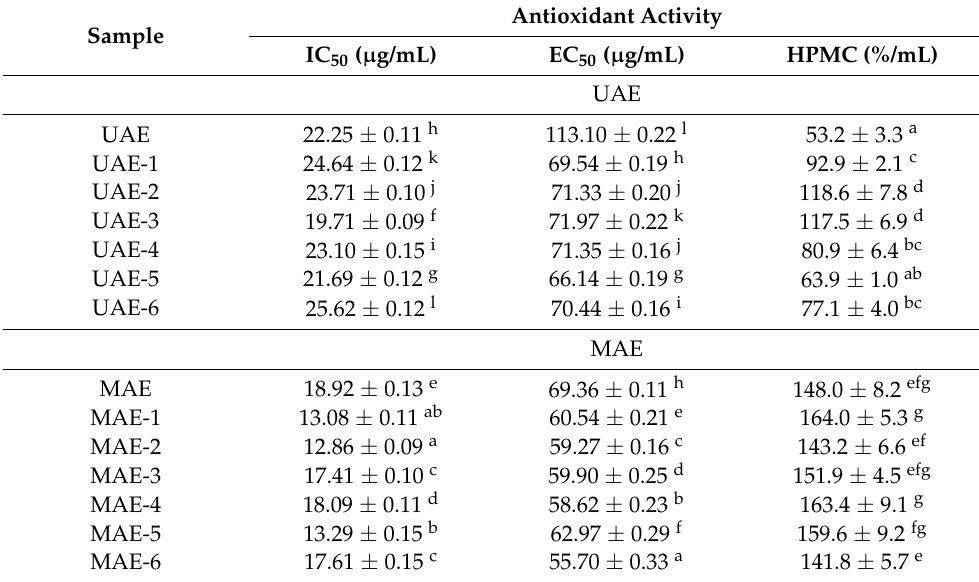
Table 5. Antioxidant activity of extract obtained from exhausted leaves.